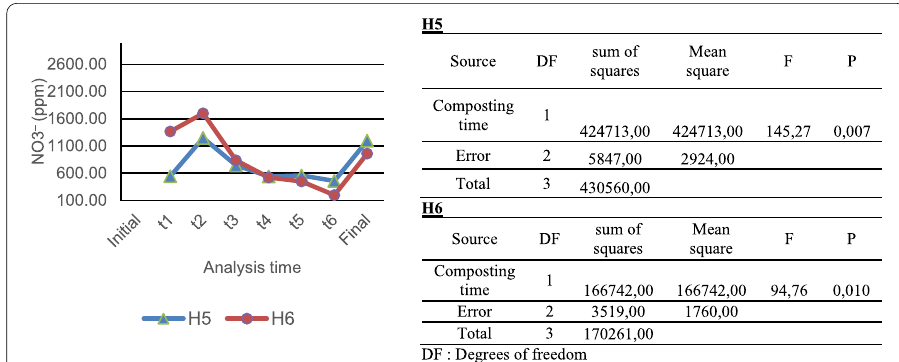
DF degrees of freedom, ASS adjusted sum of squares, SSS sequential sums of squares